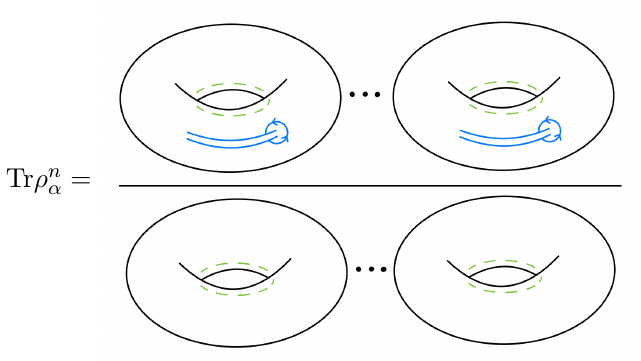
Figure 3 . The replica trick for pure ensemble state | ψ α i . The green dashed circle represent the same boundary condition for all the replicas on the inner circle. The topology of the resulted manifold ensures S vN ( ρ α ( ϕ )) = S vN ( ρ α ( ϕ )) . What is the expected behavior for S ( ϕ ) ? For β (cid:29) 1 the ensemble reduce to the vN ground-state, and S ( ϕ ) takes the universal ground-state result (3.6). When the entan- vN glement region is very small ϕ (cid:28) 1 , β we can use the twist operator OPE and recover the ground-state result